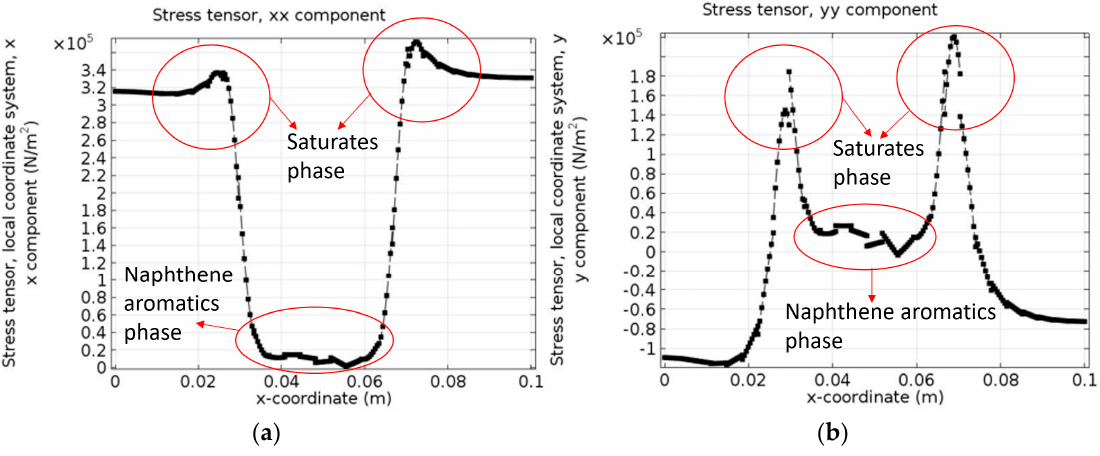
Figure 13. ( a ) xx component; and ( b ) yy component of stress tensor of bottom boundary at t = 0.5 s.